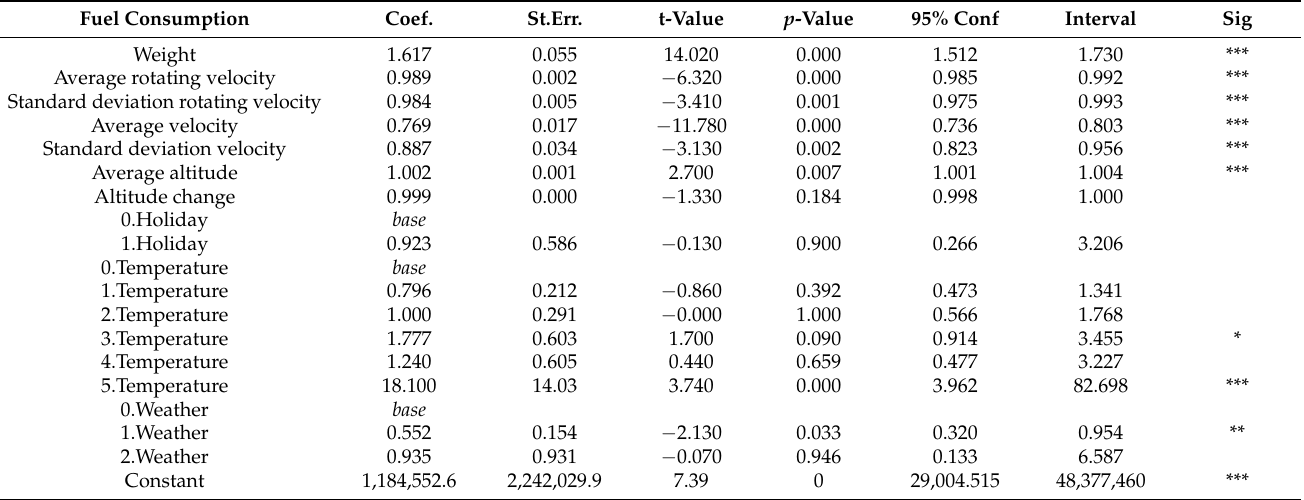
Table 6. Binary Logistic regression model